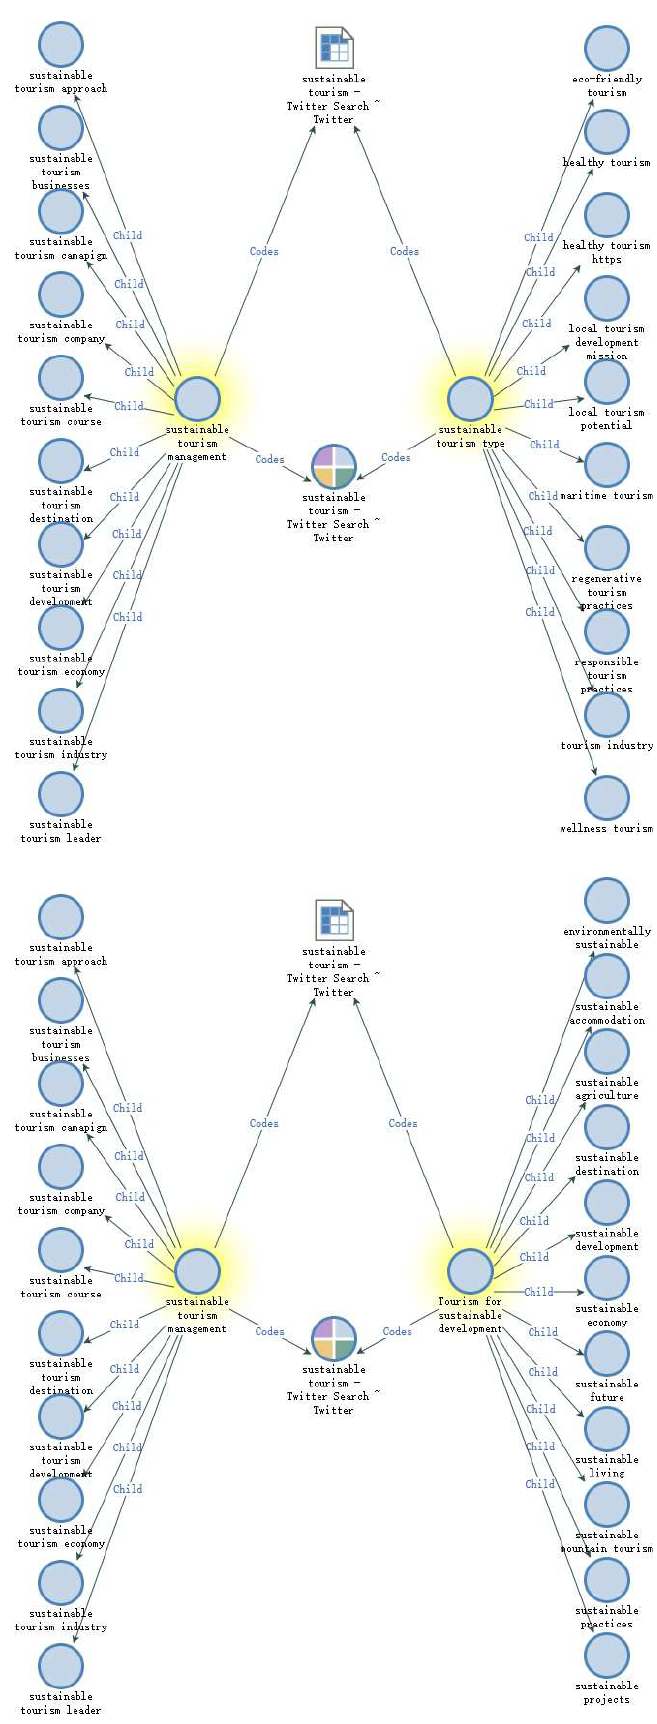
Figure 3. Comparative analysis map of the relationship between sustainable tourism management and tourism for sustainable